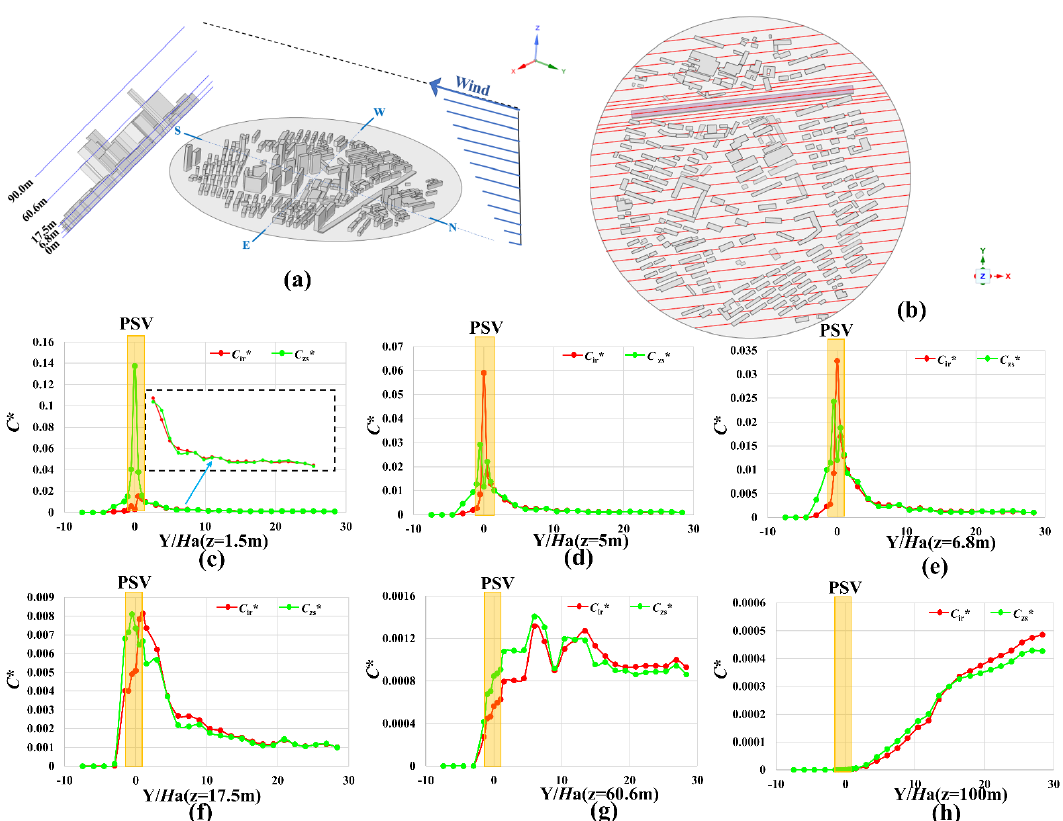
Figure 10. Buildings and normalized pollutant concentration ( C *) ( H a = 20.1 m): ( a ) A schematic diagram of dividing Z – plane; ( b ) Numerical selection distance diagram; ( c – h ) Variation of pollutant concentrations with distance from pollution sources at different plane heights.